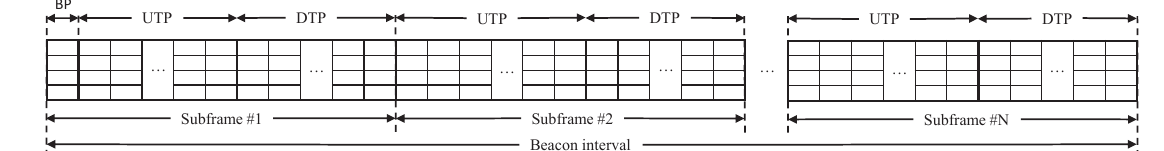
Figure 2. A frame structure for DG-LoRa.